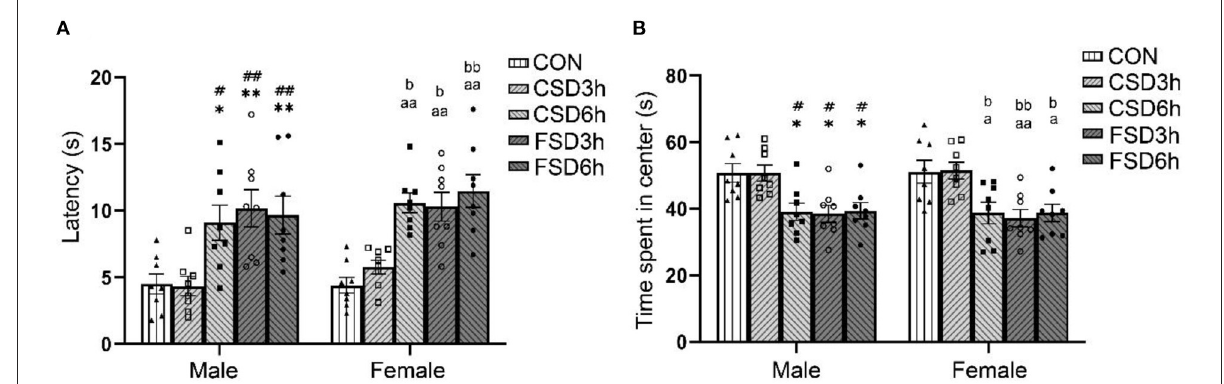
FIGURE2 Results of the open field tests (16 mice were tested per treatment group, including 8 males and 8 females). The latency and time spent in the center in the open field are depicted graphically. A longer latency period and a shorter center time were regarded as increased anxiety-like behaviors. (A) Latency in the open field. (B) Time spent in the center. * P < 0.05 and ** P < 0.01 vs. Male CON group; # P < 0.05 and ## P < 0.01 vs. Male CSD3h group; a P < 0.05 and aa P < 0.01 vs. Female CON group; b P < 0.05 and bb P < 0.01 vs. Female CSD3h